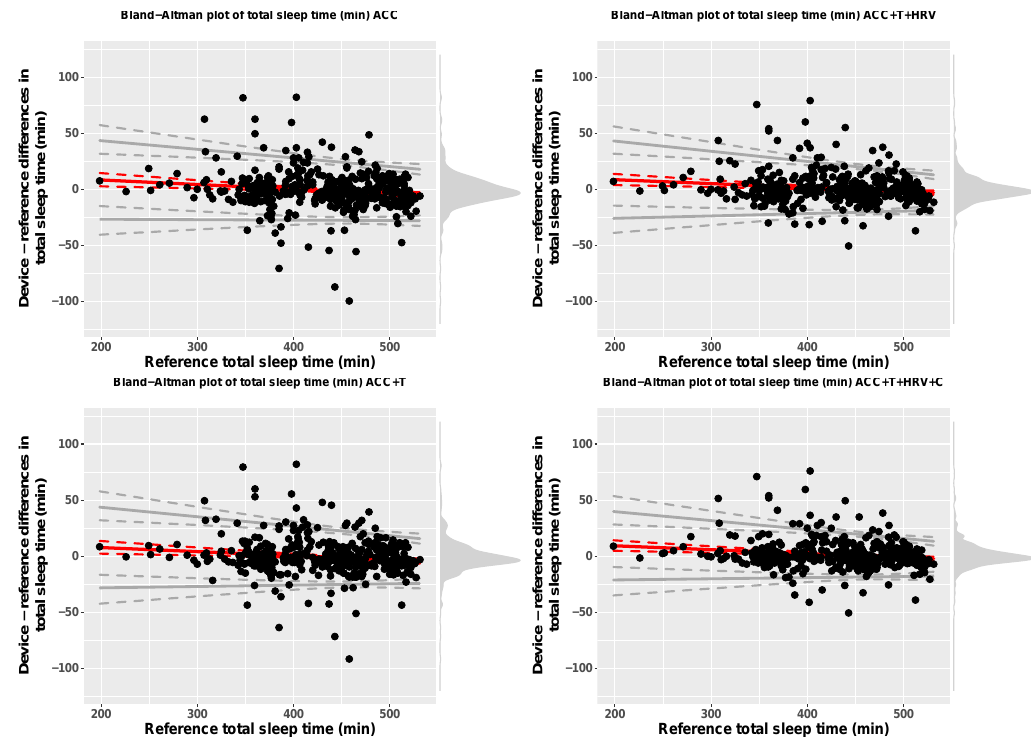
Figure 5. Bland-Altman plots for total sleep time (TST), 2-stage classification, and the four models compared in this